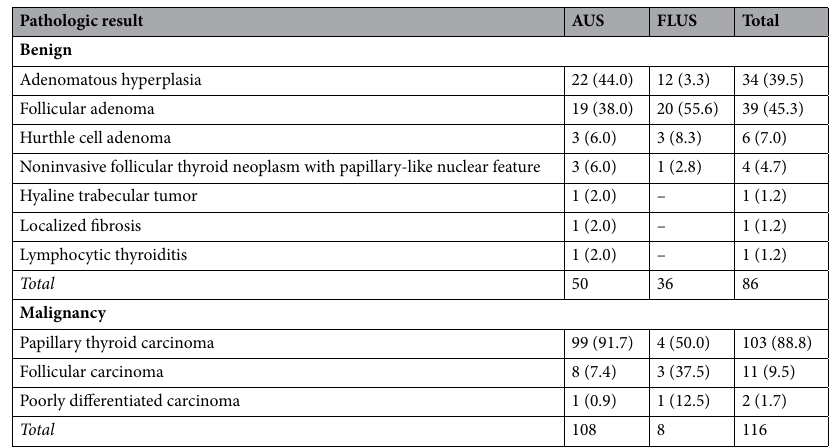
Table 2. Pathologic results after surgery. Data in parentheses are percentages. AUS atypia of undetermined significance, FLUS follicular lesion of undermined significance.